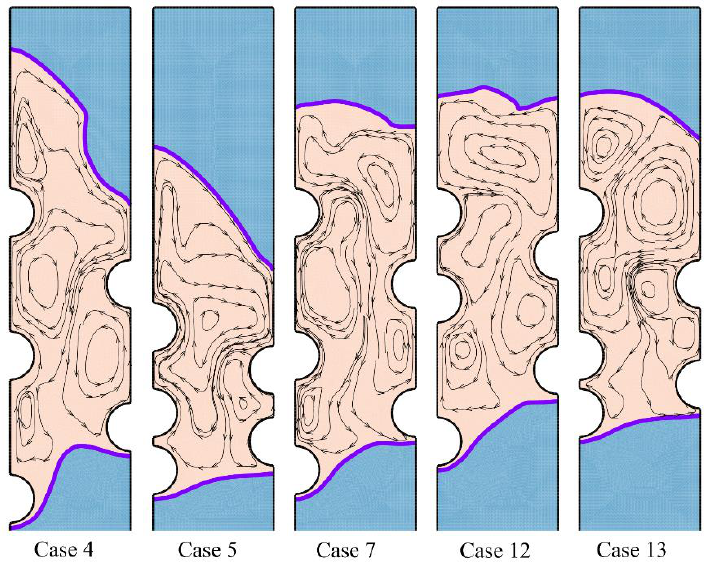
Figure 8. The streamlines and phase change interfaces for five different tubes ’ arrangement after two hours of charging.